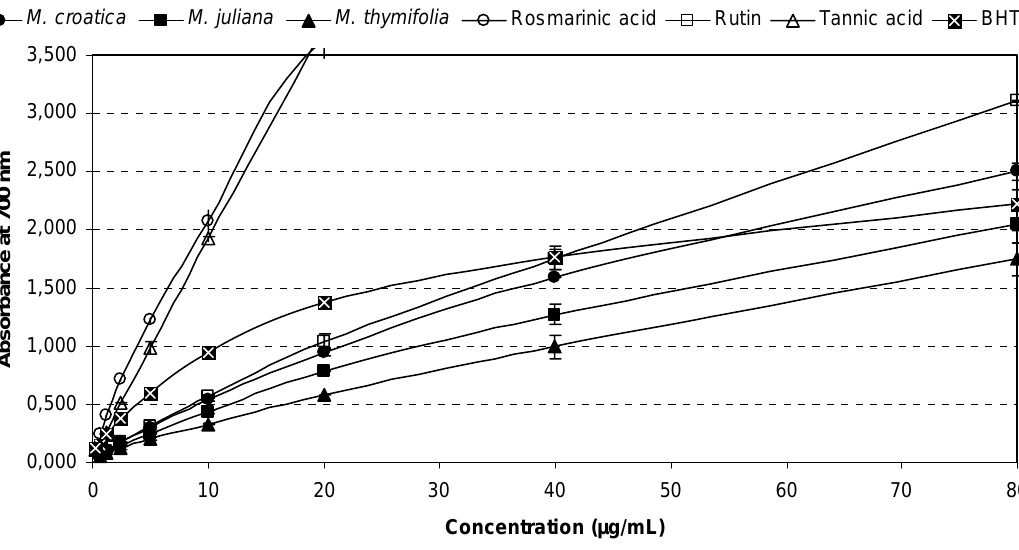
Figure 4. Reducing power of Micromeria ethanolic extracts in comparison with polyphenolic compounds and a reference